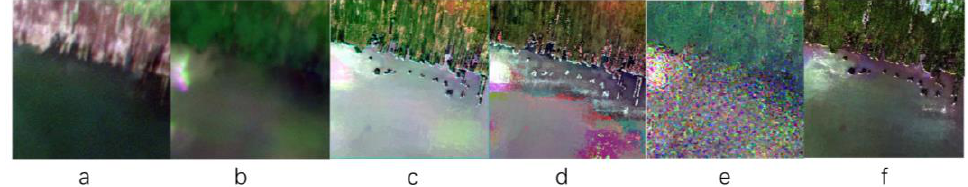
Figure 2. ( a ) PS image on 15 April; ( b ) PS image on 10 July; ( c ) fusion image by FSDAF on 10 July; ( d ) fusion image by STDFA on 10 July; ( e ) fusion image by Fit_FC on 10 July; ( f ) GF-2 verification image on 13 July.